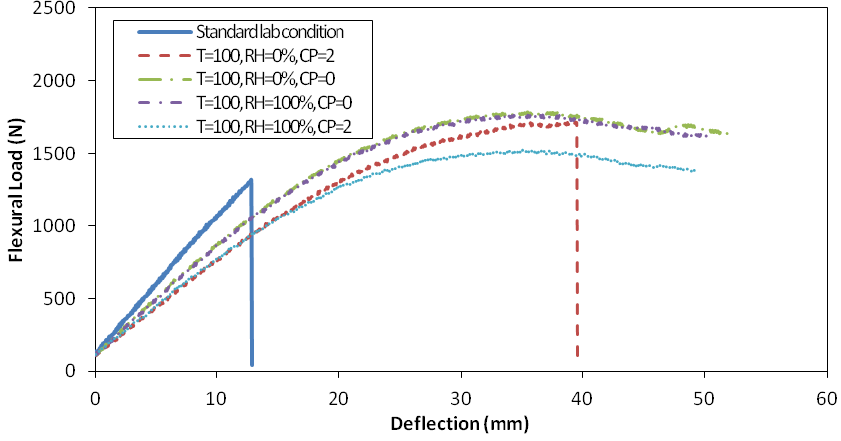
Figure 6. Flexural load-mid span deflection curves after 100 cycles under the conditions of 100 °C, humidity (0% and 100%), cycle period (Cp = 0 and 2).